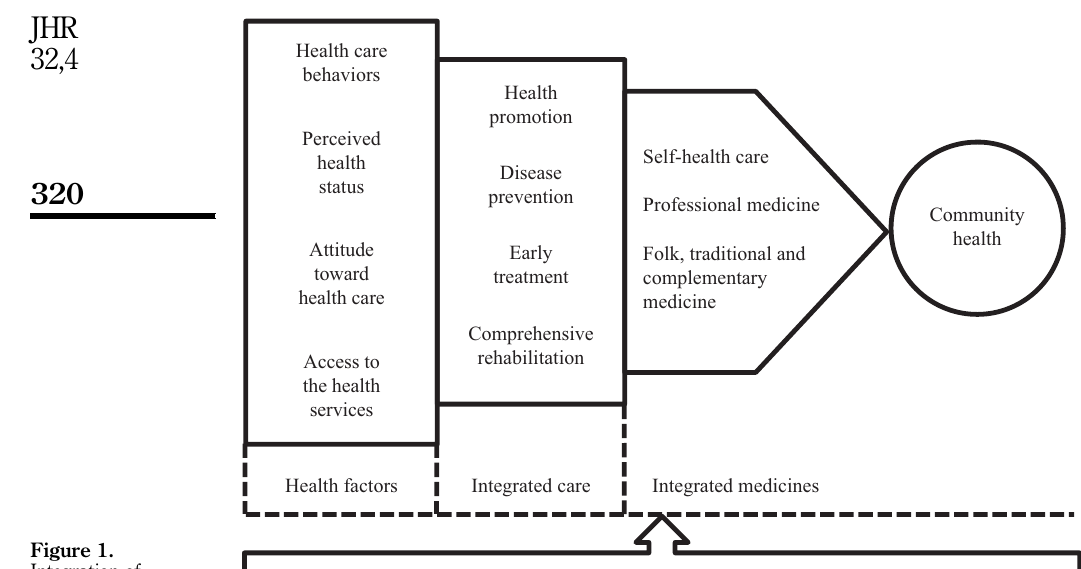
Figure 1. Integration of medical